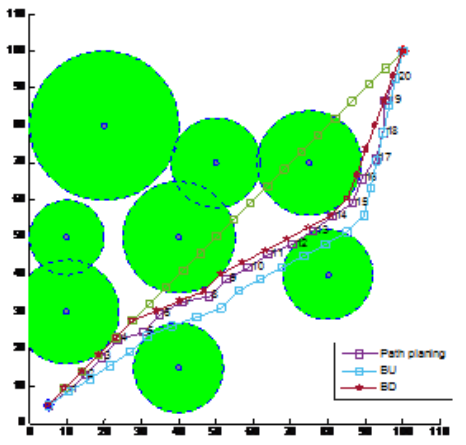
Fig. 10 Path planning by EFWA when n=20